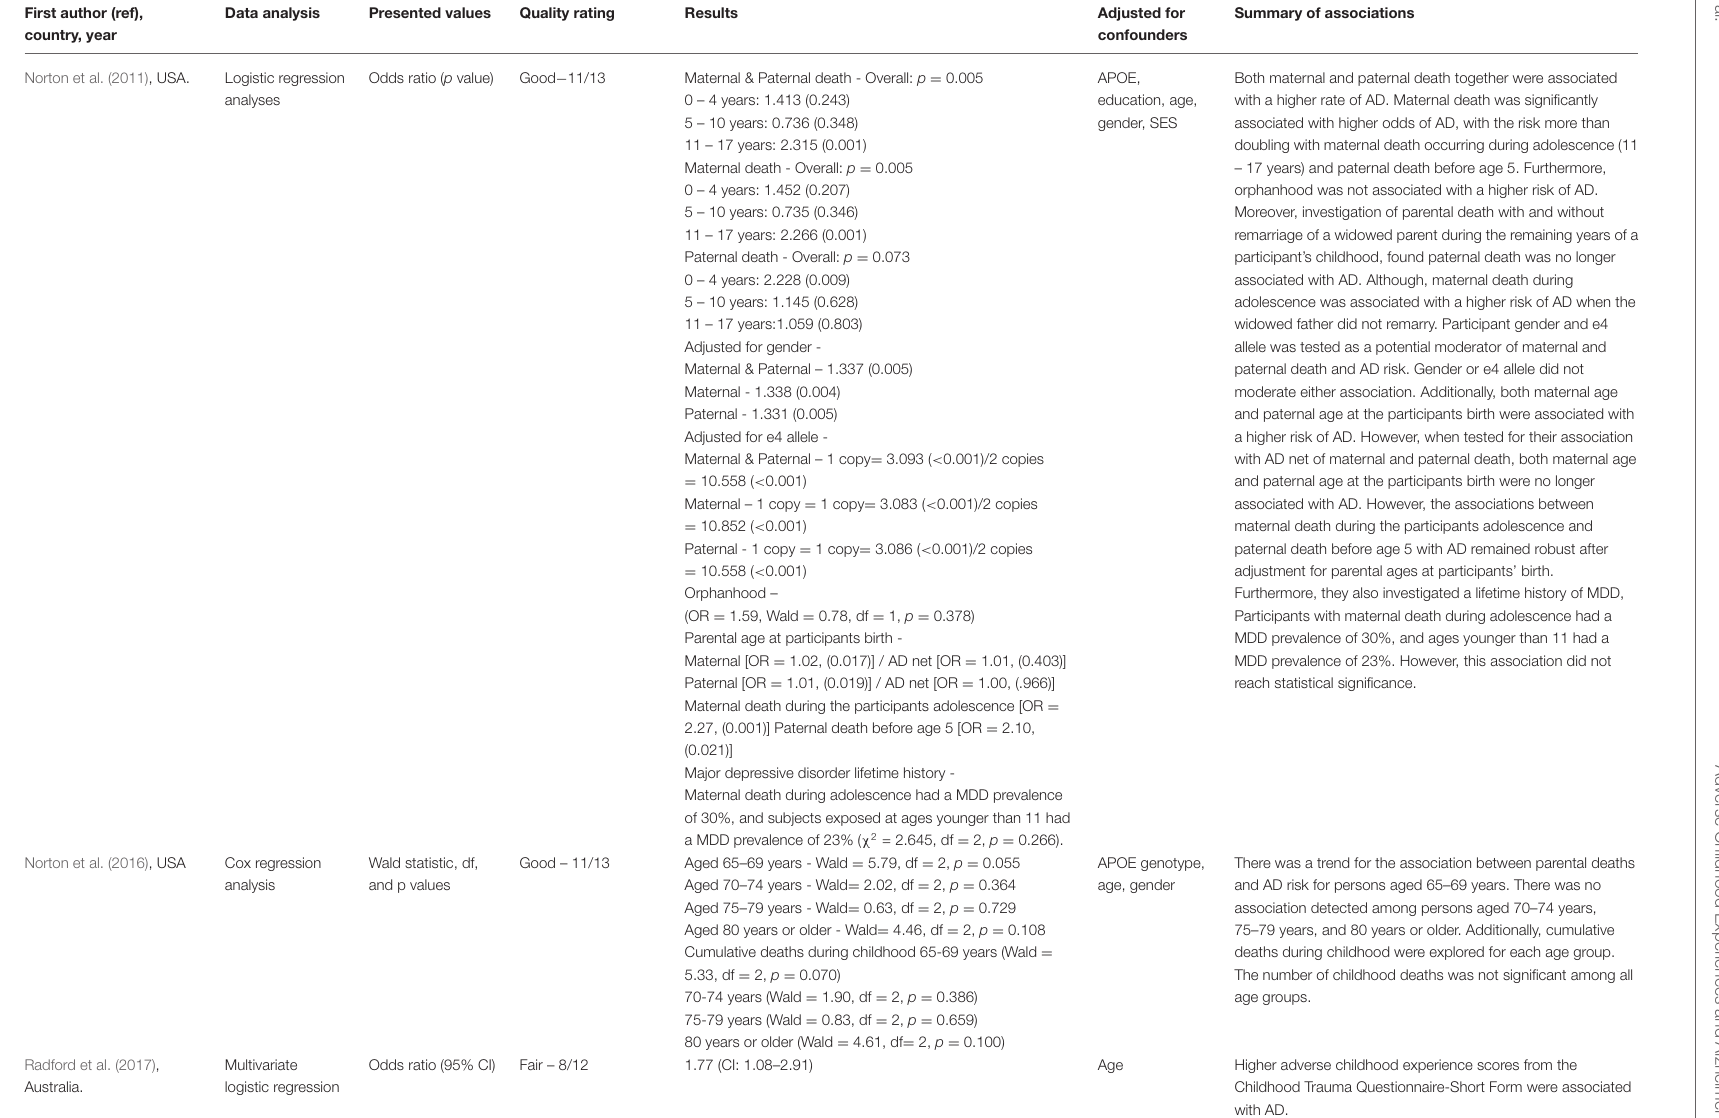
TABLE 3 | Results of eligible studies included in this review pertaining to the association between ACEs and